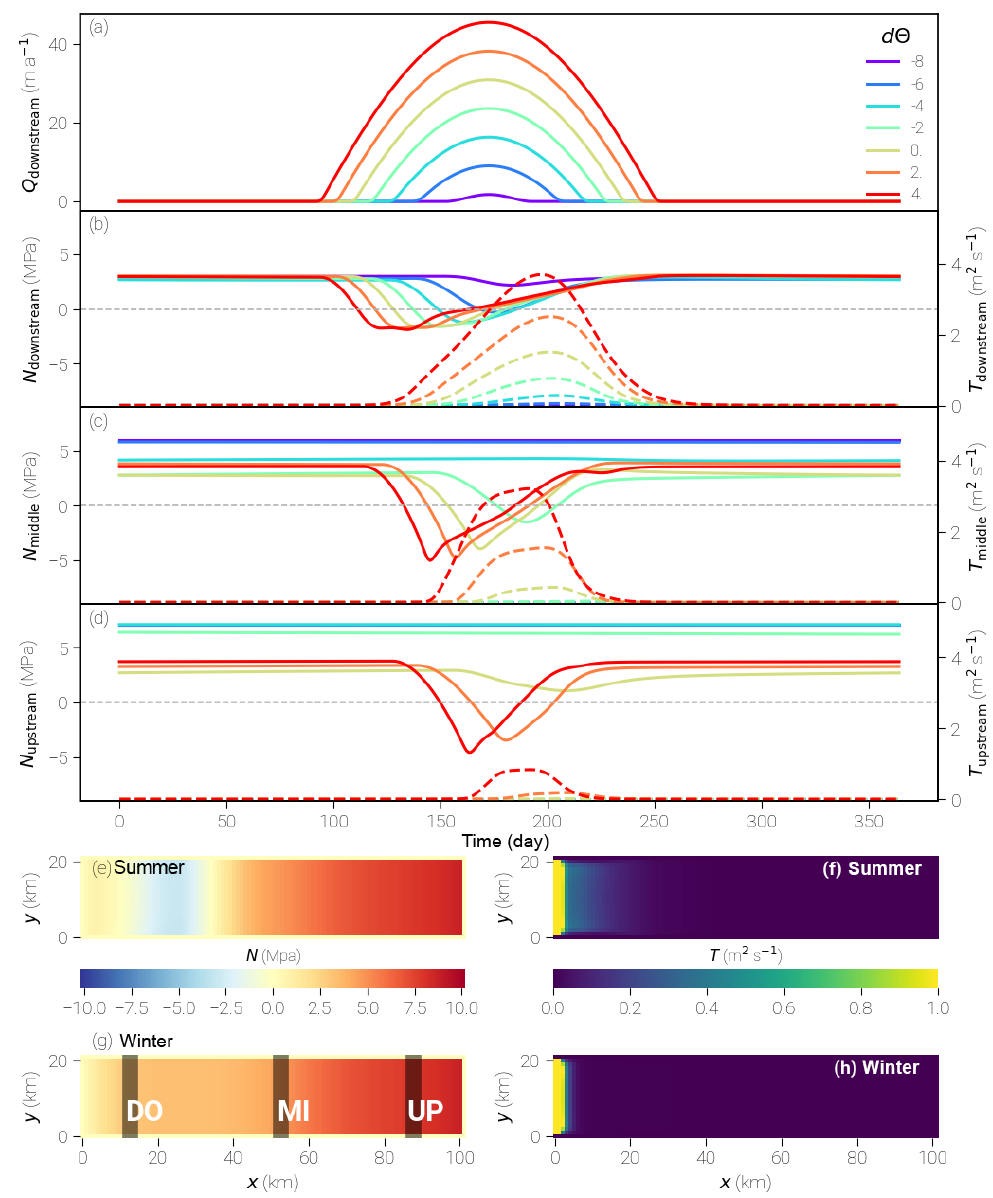
Figure 6. Results for one season of the SHMIP/D experiment. In panels (b) – (d) , the left axis (effective pressure) corresponds to the solid lines, while the right axis (transmissivity) specifies the values for the dashed lines. The values at the given positions (upstream, middle, downstream) are averaged over the corresponding areas indicated in panel (g) . Panels (e) – (h) show two-dimensional distribution maps of d (cid:50) = − 4